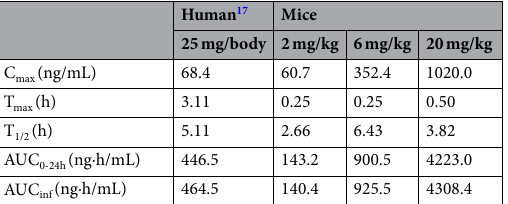
Table 1. Pharmacokinetic parameters after meclozine administration. C max = Peak drug concentration; T max = Time to peak drug concentration; T 1/2 = Terminal elimination half-life; AUC 0–24h = Area under the concentration-time curve from time zero to the last sampling time; AUC inf = Area under the concentration- time curve from zero to